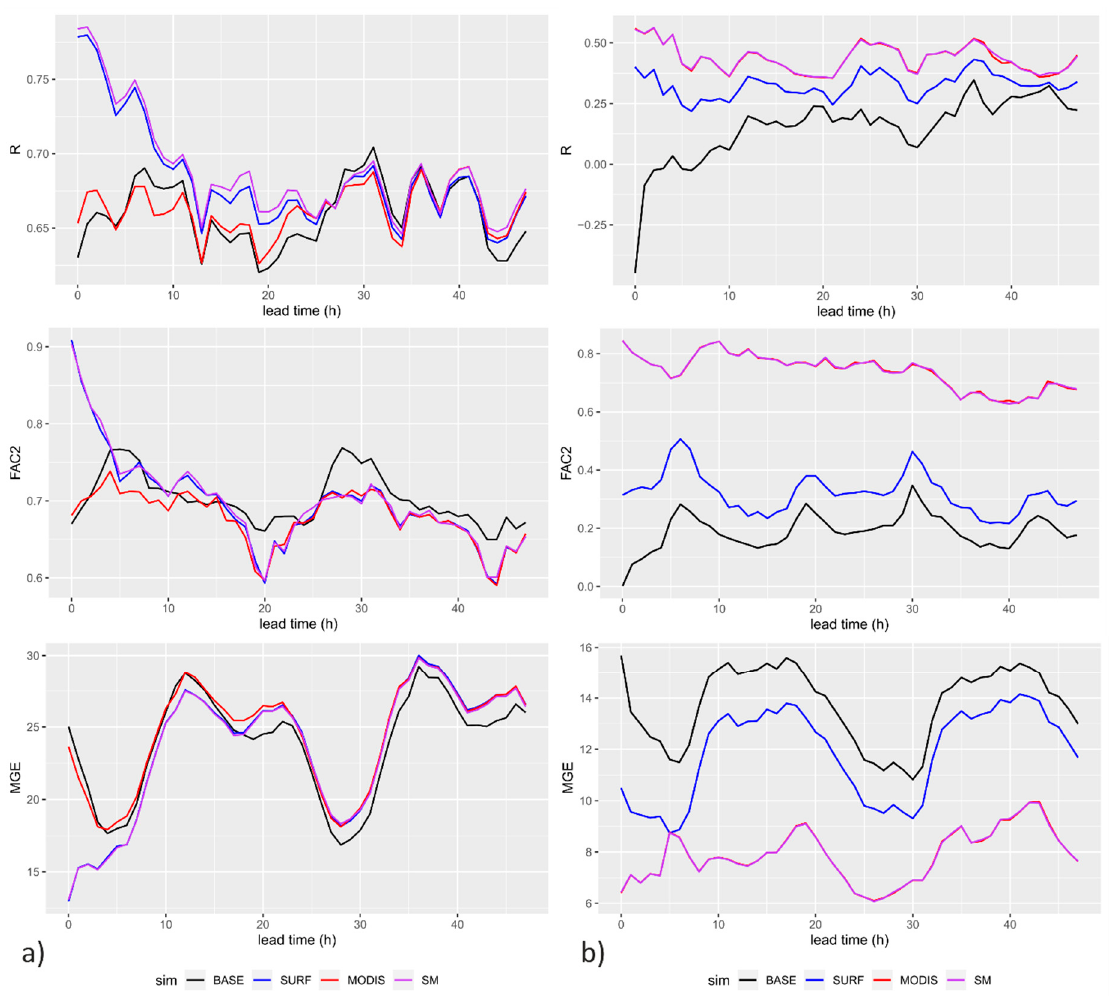
Figure 4. R, FAC2, and MGE according to the lead time for PM2.5 concentrations for ( a ) winter 2017 and ( b ) summer 2015 episodes over Poland. Unit for MGE is µ g m − 3 ; FAC2 and R are dimensionless.